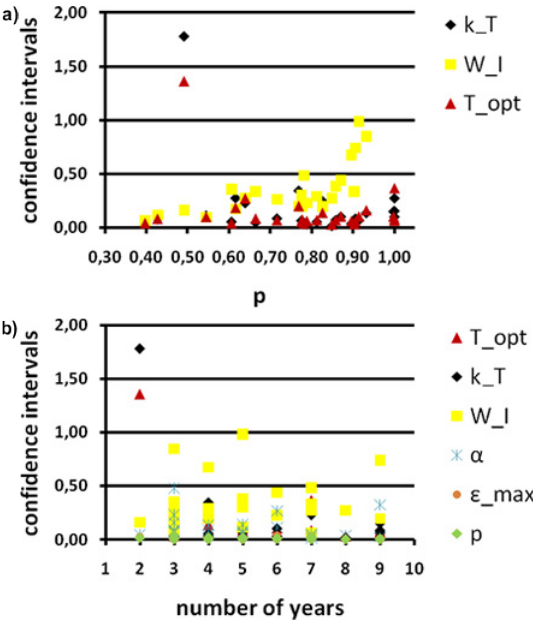
Fig. 9. 95% confidence intervals of the calibrated model parameters k T , W I and T opt of the model subfunctions f T and f W (see Eqs. 15– 17) in relation to the calibrated values of p (a) , and the 95% con- fidence intervals of all model parameters in relation to the number of available measurement years used to calibrate the model (b) with SWC as water availability